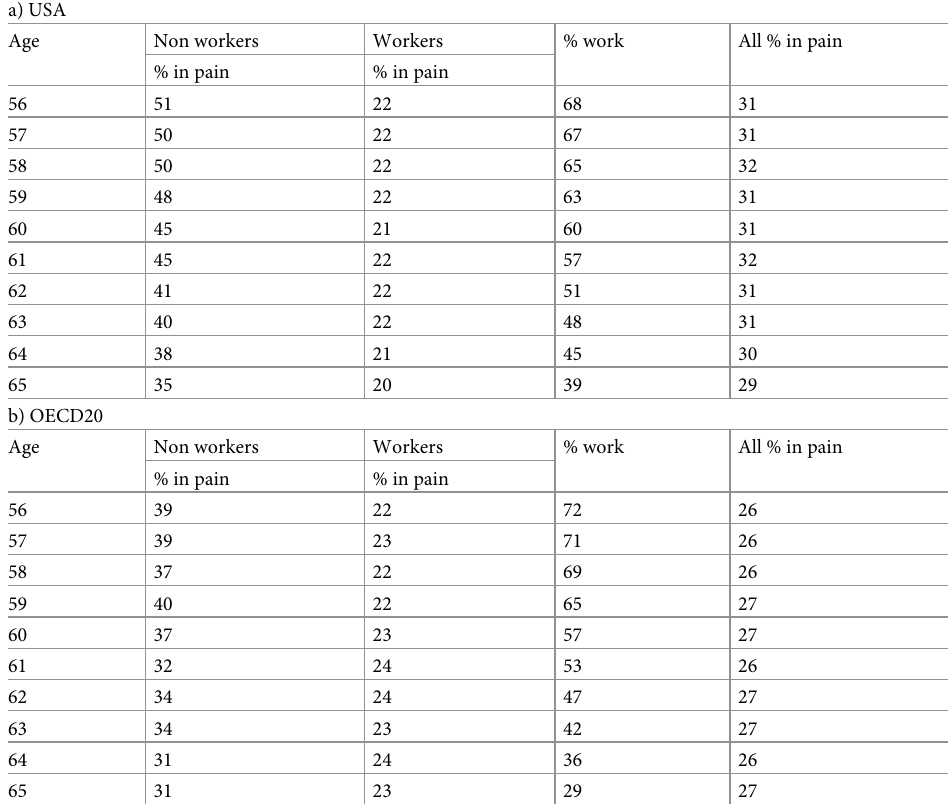
Table 2. Pain simulated for non-workers by age, USA (2009–2017) and OECD20 (2005–2020).